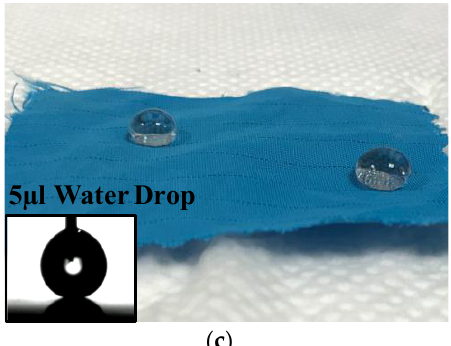
Figure 3. Images of the fabrics after plasma processing: ( a ) Water and soya oil drops on the plasma micro-nanotextured PES fabric A; ( b ) Water drops on the plasma micro-nanotextured PES fabric B; ( c ) Water drops on the plasma micro-nanotextured PES fabric C. Water and soya drops (5 µ L) as shown as insets, images captured from GBX Digidrop system.